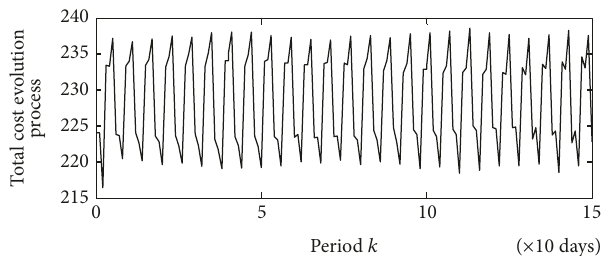
Figure 11: Ordering evolution processes under the fuzzy robust strategy ( ×10 4